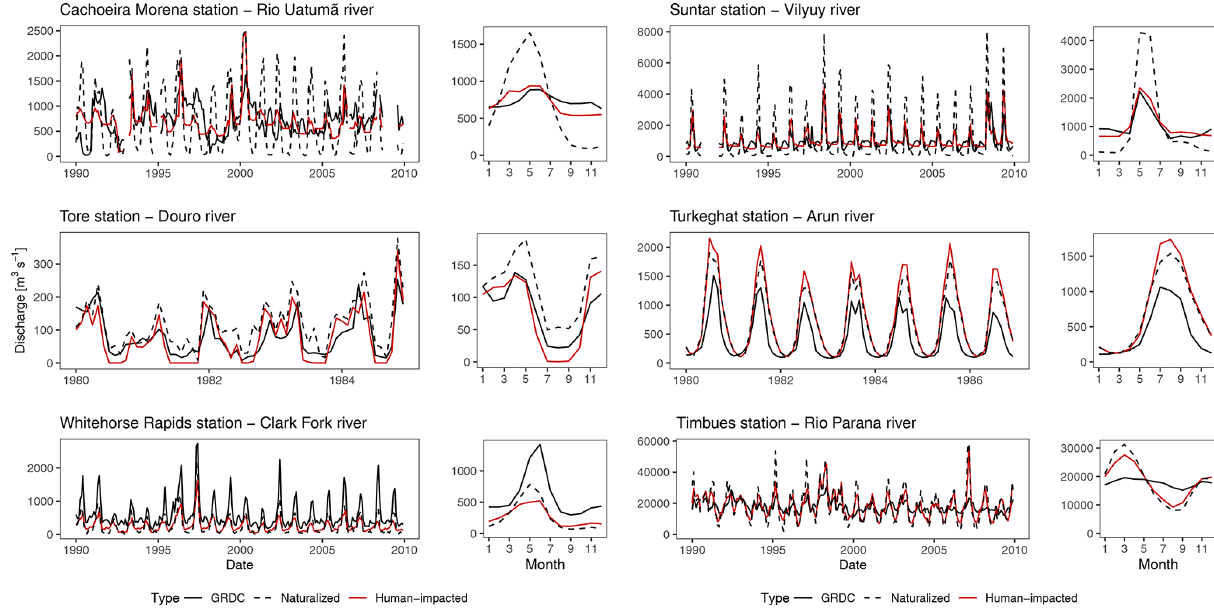
Figure 7. Comparison between the simulated discharge and GRDC-observed values. Panels indicate the time series and multiyear averages for naturalized simulations (dashed), anthropogenically impacted simulations (red), and observed (black)